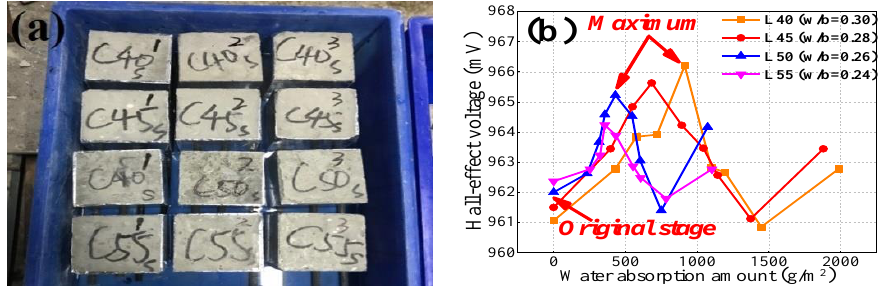
Figure 10. Water absorption test: ( a ) experimental diagram and ( b ) the relationship between Hall effect voltage and water absorption amount.